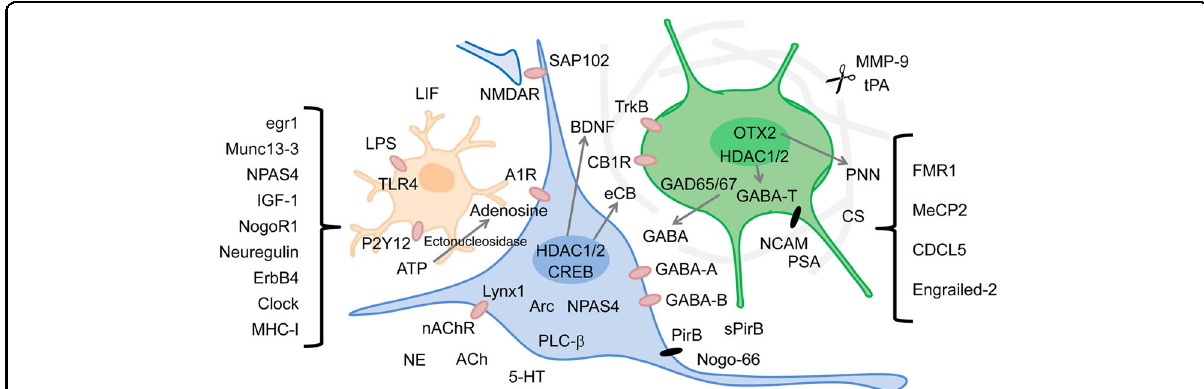
Fig. 1 Factors modulating the critical period. Factors that are known to control the critical period to date are depicted in the area where they operate predominantly. Factors with unclear action sites are listed on the left side and the neurodevelopmental disease-related factors are listed on the right side. The green cell is a PV ( + ) inhibitory neuron, the blue cell is a pyramidal neuron, and the orange cell is a glia cell (microglia). Perineuronal net is depicted in pale gray. Receptors or channels are red and cell adhesion molecules are